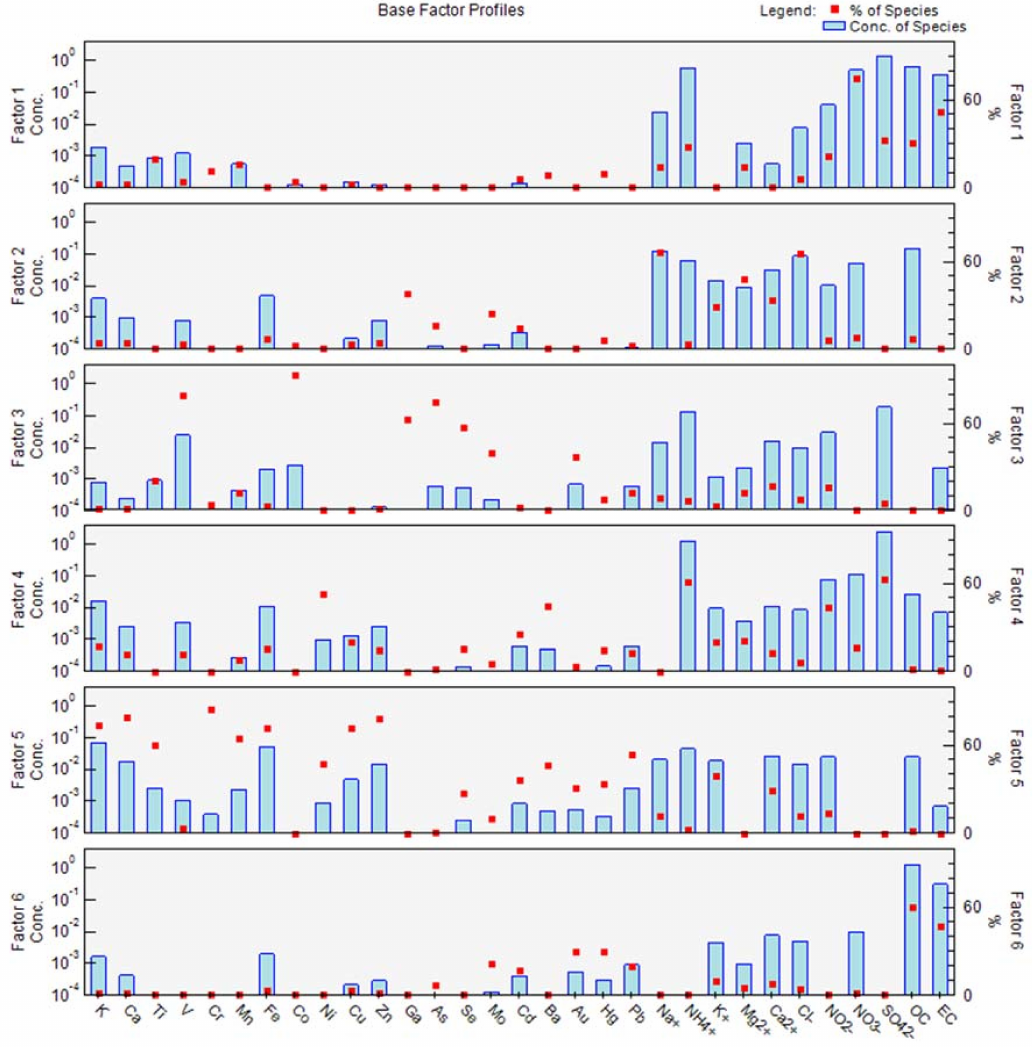
Figure 8. PMF analysis of the distribution of PM 2.5 emission sources during the monitoring period (units: µ g/m 3